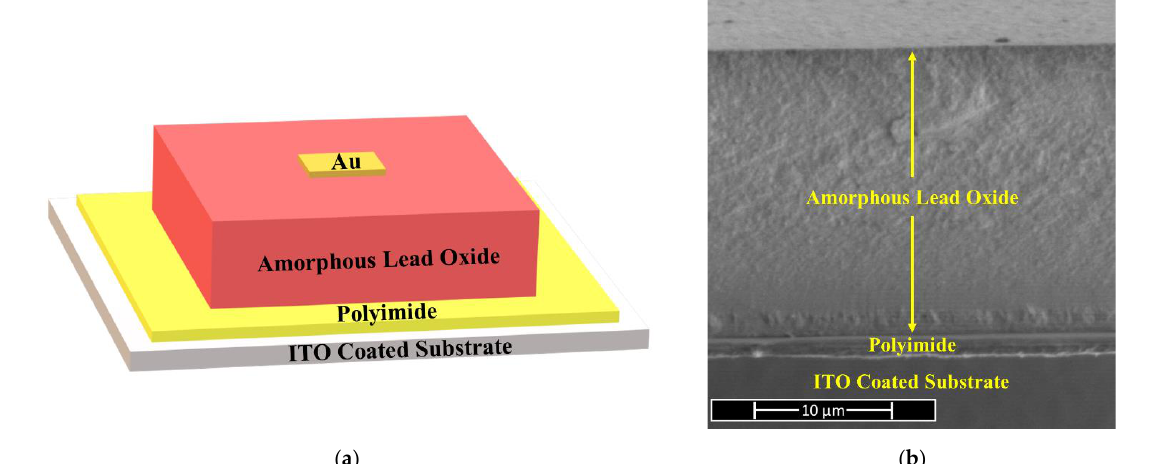
Figure 1. ( a ) Schematic diagram (not to scale) and ( b ) a cross-sectional scanning electron microscopy (SEM) image of a single-pixel PI/a-PbO direct conversion X-ray detector.